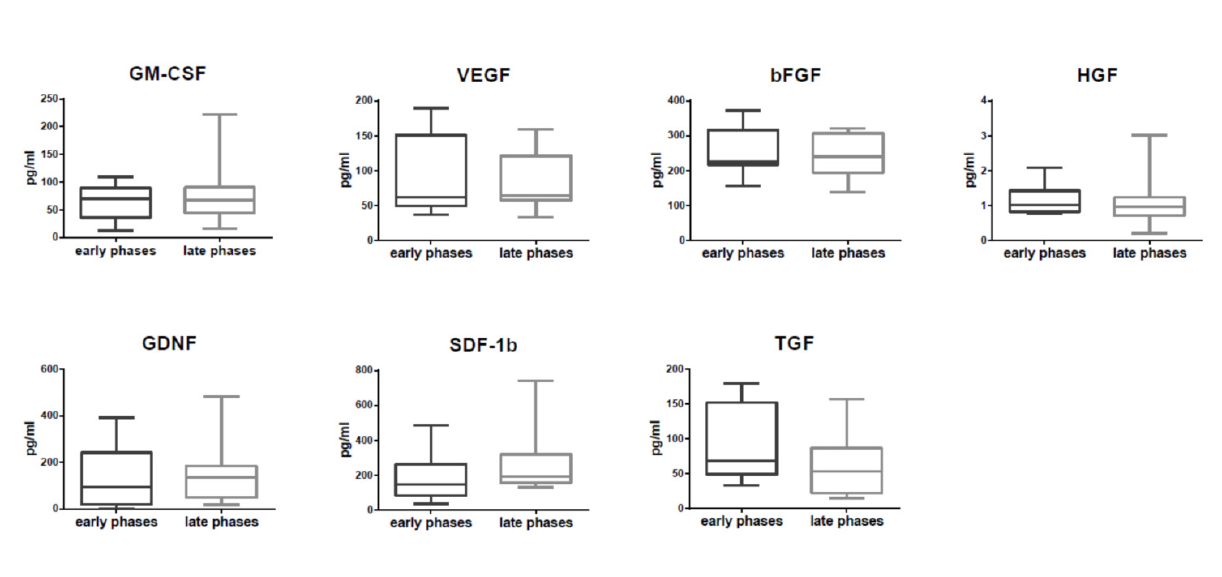
Fig. 3. Comparison of serum growth factor and cytokine levels in the early and late phases of tissue healing. There were no significant differences. Early phases represent necrotic areas and granulation tissue, whereas late phases represent fibrous scars.